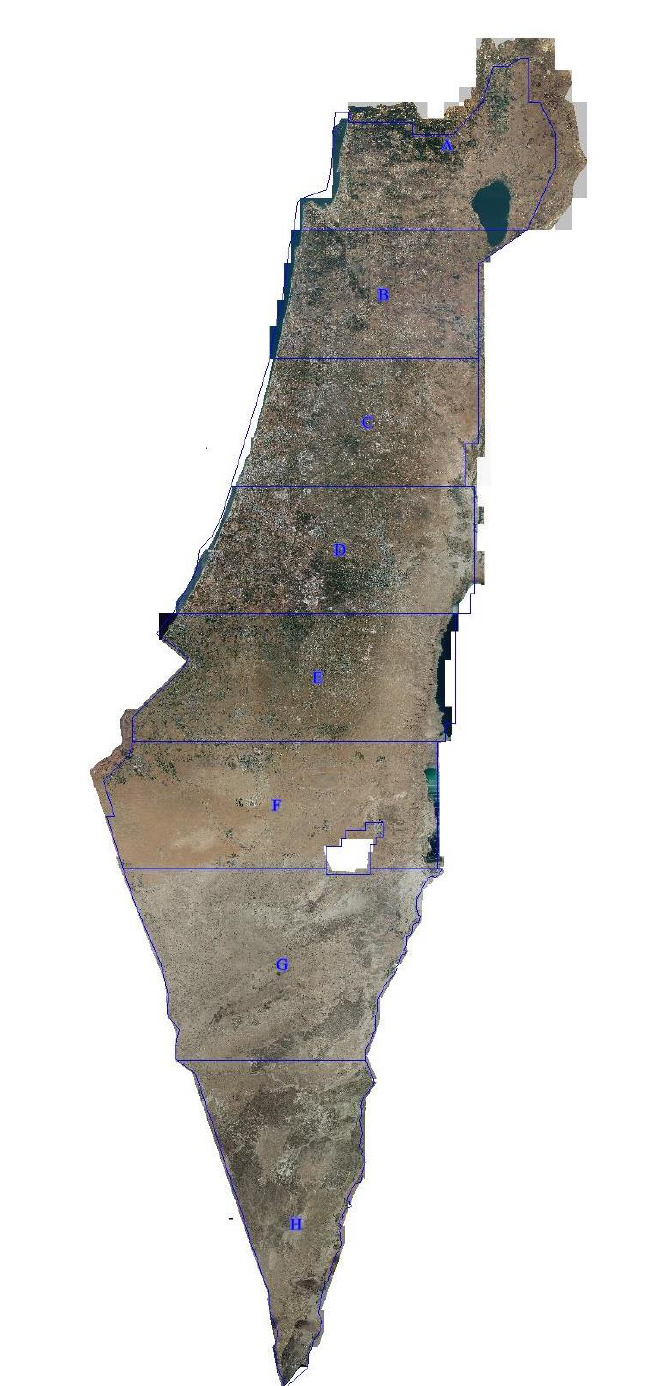
Figure 4 : the 8 areas division of Israel and the 2021 ortho